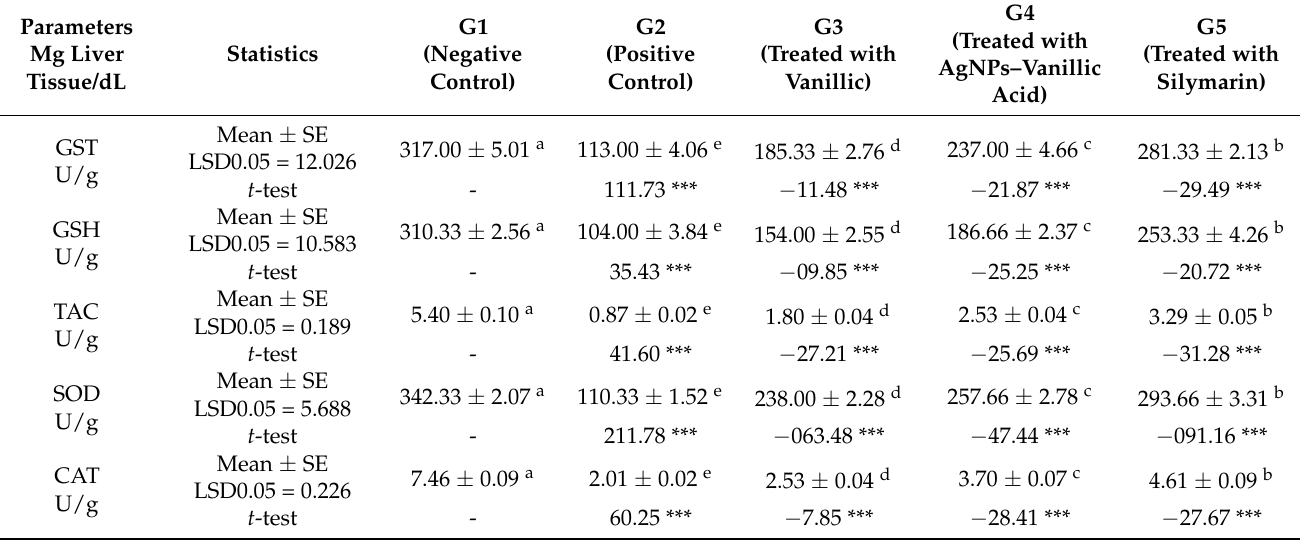
Table 2. The effects of vanillic acid-loaded silver nanoparticles on TAC and antioxidant enzymes in liver tissues of CCl 4 liver toxicity-induced rats.